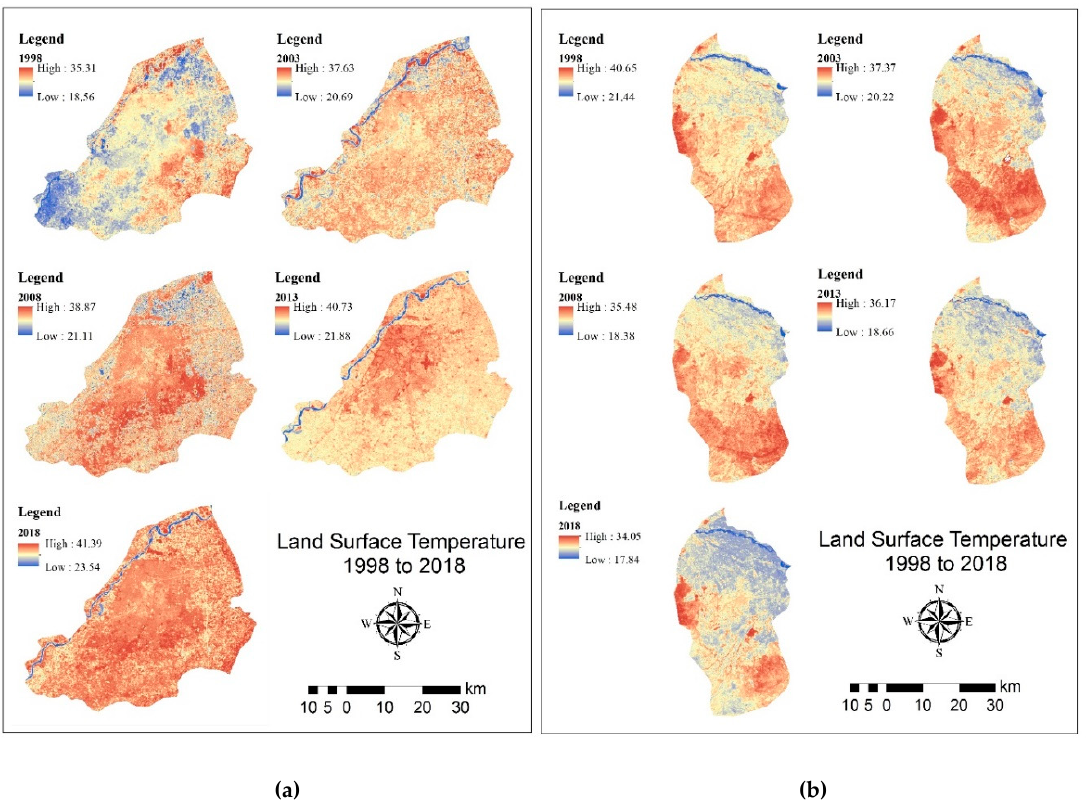
Figure 7. Spatial patterns of land surface temperature (LST, ◦ C) in Lahore ( a ) and Peshawar ( b ), averaged over 3 months (May–July), for each study year.